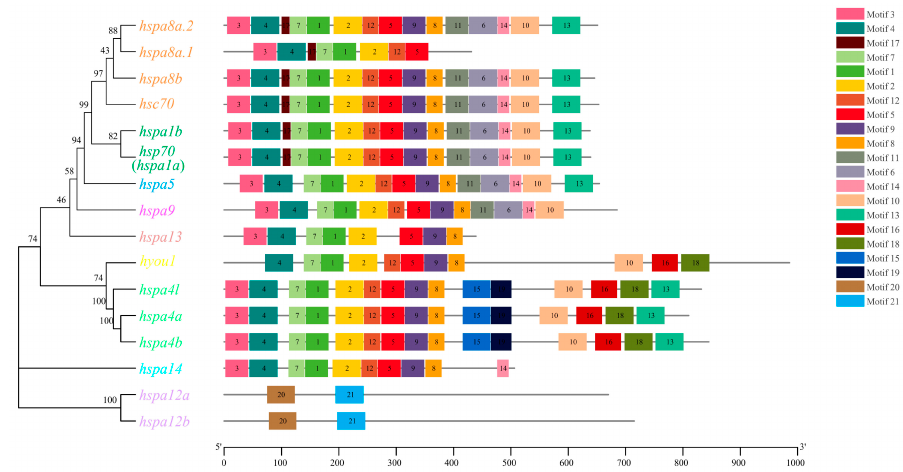
Figure 4. The combination of phylogenetic relationship and conserved motifs. The left of the graph shows the phylogenetic relationships of S. maximu HSP70 genes. The right of the graph shows the distribution of conserved motifs and each colored rectangular box represents a motif.